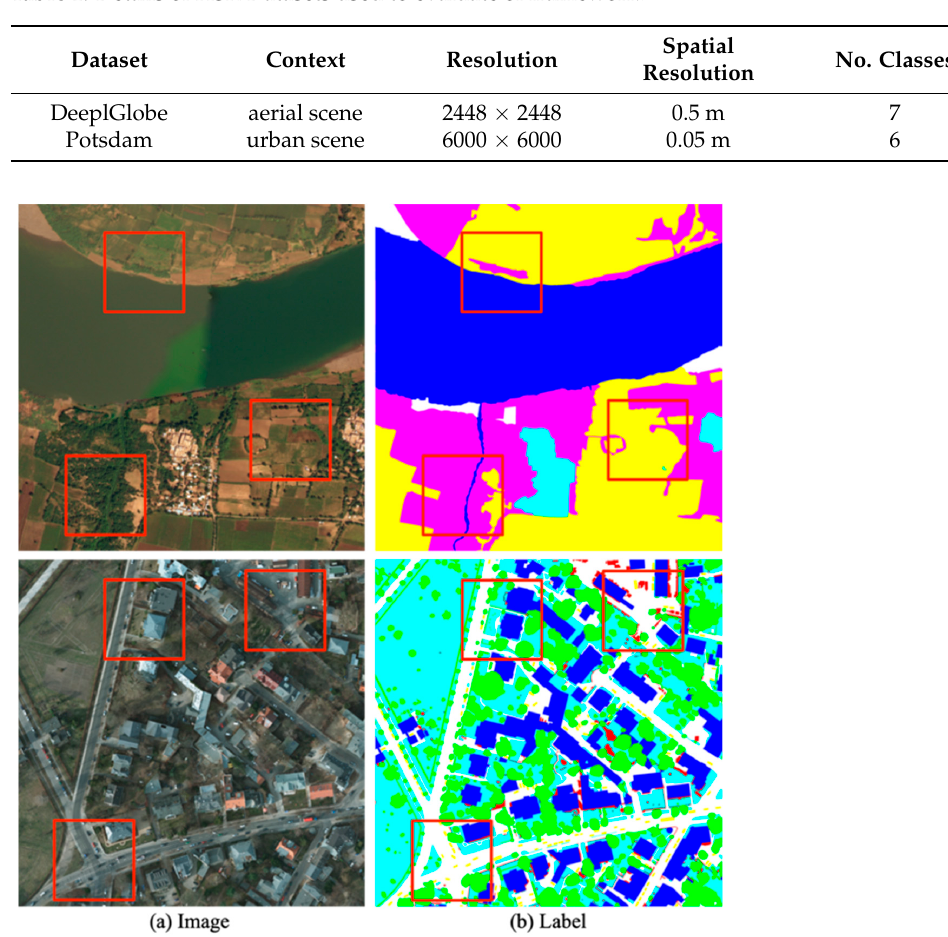
Figure 6. Dataset of DeepGlobe and Potsdam. The red area framed from the picture is the area that is difficult to segment.